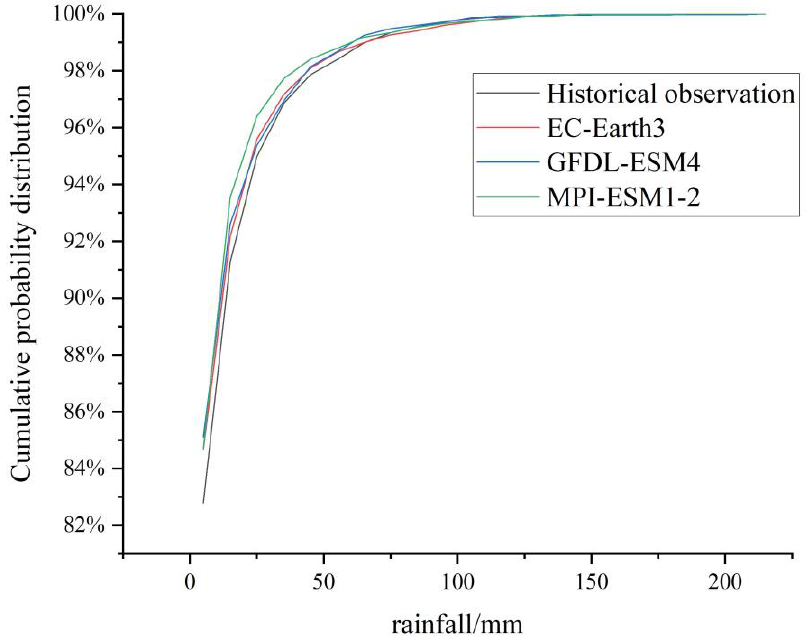
Figure 3. The curves of the cumulative probability distribution of the observed data and three models’ downscaled data.